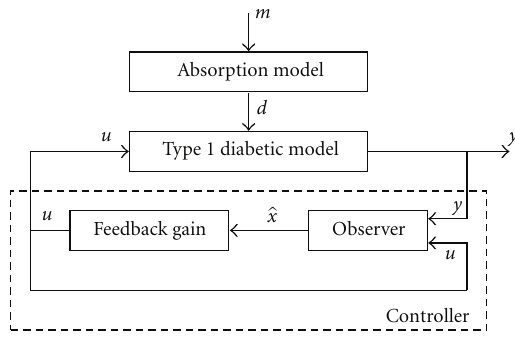
Figure 5: Structure of the closed-loop